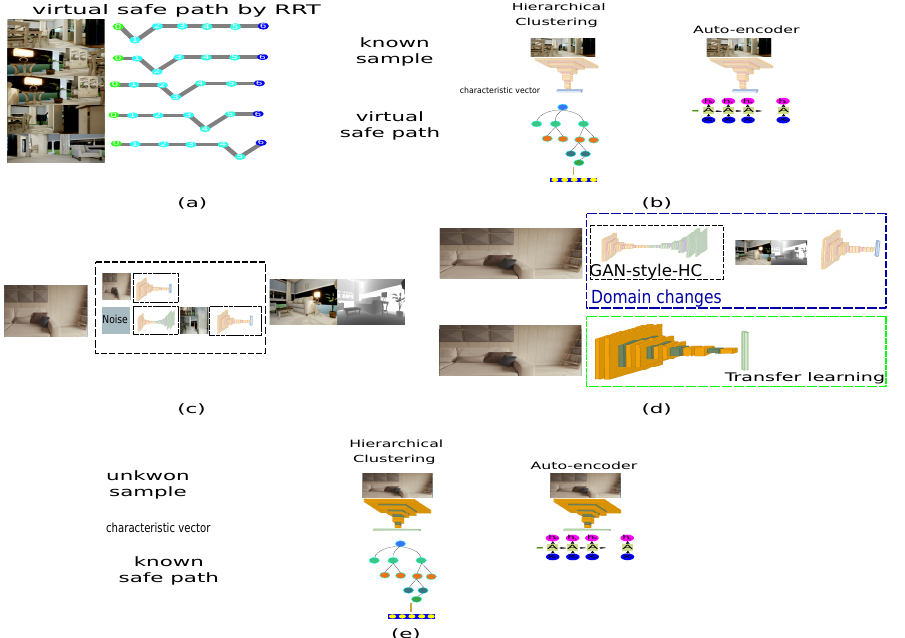
Figure 11. Proposed architecture to generate a path in augmented reality applications on embedded devices employing unpaired samples. ( a ) Virtual path associated with each virtual sample. ( b )